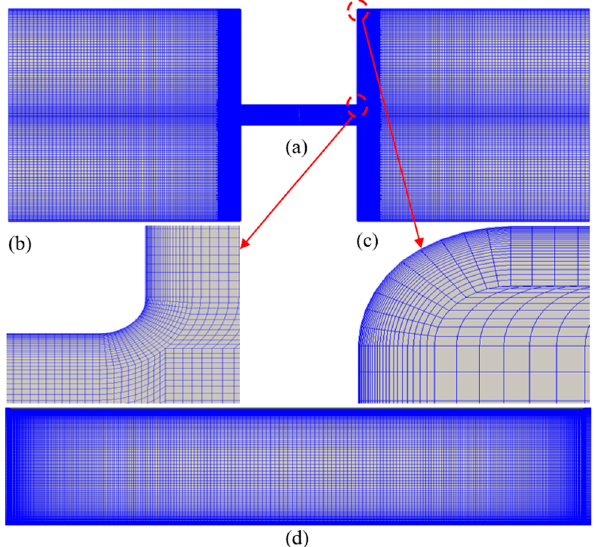
Figure 2. Computational mesh used in the numerical simulations. Mesh of the whole geometry ( a ) and detailed view of the mesh at channel corner ( b ), at reservoir corner ( c ), and in the constriction microchannel ( d ).